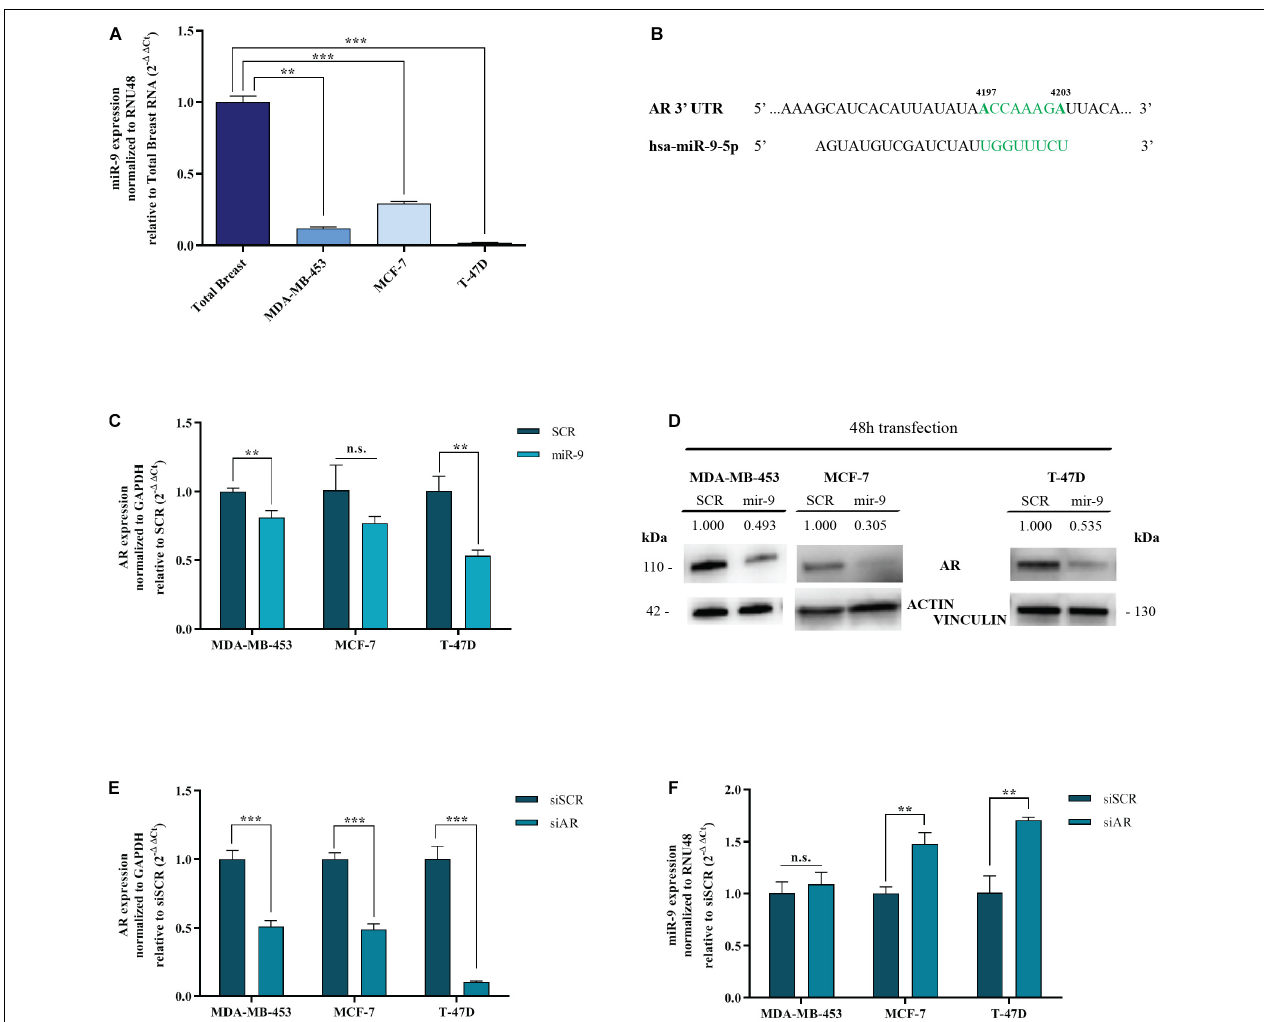
FIGURE 1 | MiR-9-5p is downregulated in BC cell lines and down-regulates AR. (A) MiR-9-5p (mir-9) expression was measured by qRT-PCR in three BC cell lines and compared to Total Breast RNA. (B) Predicted miR-9-5p target sites in the AR 3 (cid:48) UTR mRNA, as shown by the Software TargetScan Human Release v6.2. in green, the seed region of miR-9::AR mRNA predicted interaction. (C) mRNA expression level of AR in MDA-MB-453, MCF-7, and T-47D cell lines, 48 h after transfection with pre-miR-9-5p (miR-9), or scrambled (SCR). (D) Protein expression level of AR in MDA-MB-453, MCF-7 and T-47D cell lines, 48 h after transfection with pre-miR-9-5p (miR-9), or scrambled (SCR). (E) AR levels after transfection of MDA-MB-453, MCF-7, and T-47D cell lines with AR siRNA (siAR) compared to scrambled (siSCR). (F) MiR-9-5p (miR-9) expression in MDA-MB-453, MCF-7, and T-47D cell lines after 48 h transfection with AR siRNA (siAR) or scrambled (siSCR). ** p < 0.01, *** p < 0.001, n.s., not significant. Multiple t -test, corrected for multiple comparison using the Holm-Sidak method in (A–D)